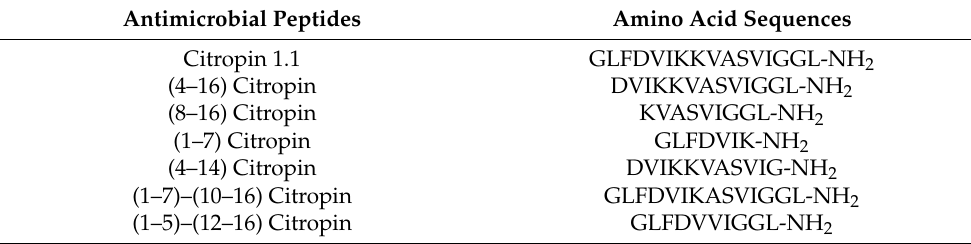
Table 3. Amino acid sequences of the studied analogs of citropin